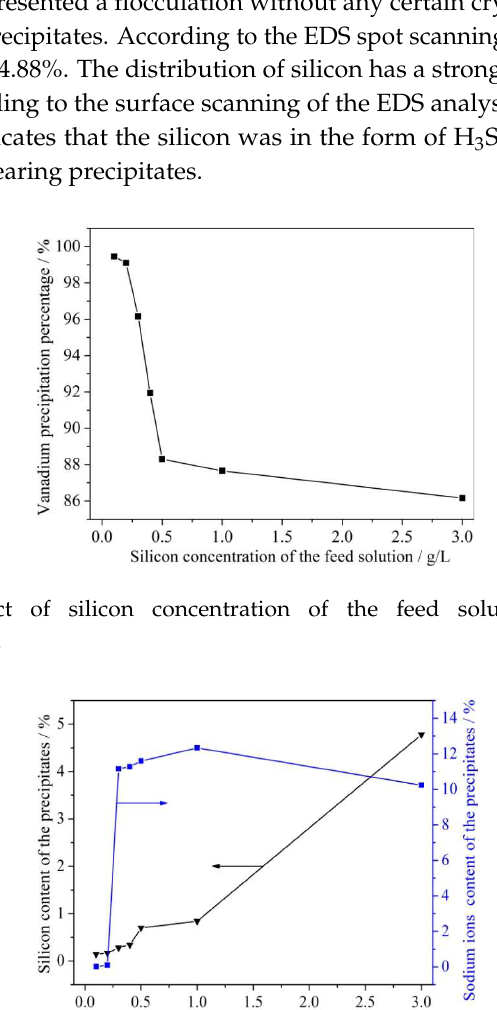
Figure 10. The effects of silicon concentration of the feed solution on the silicon and sodium ions content of the precipitates.